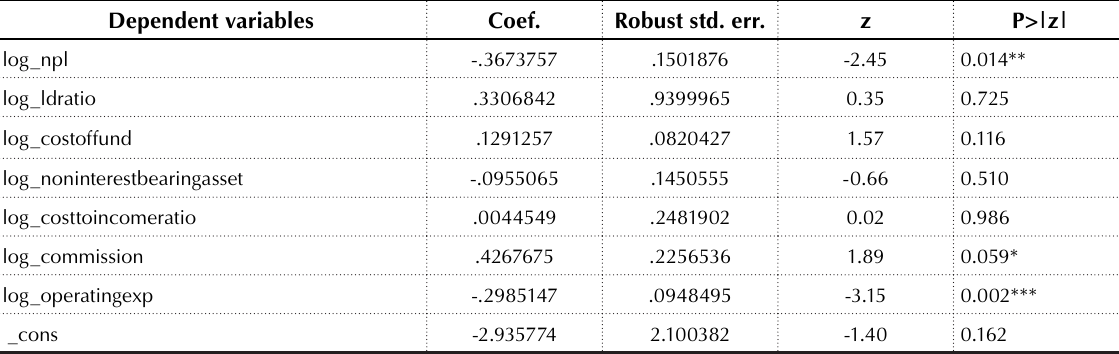
Table 4. Model 4 (determinants of return on equity, robust